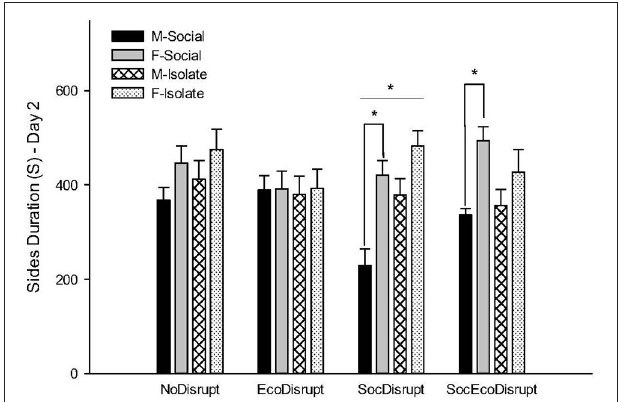
FIGURE 1 | Time spent on the sides of the arena, close to the walls, by two groups of voles: adult males (M-Social) and females (F-Social) that were socially housed and adult males (M-Isolate) and females (F-Isolate) that were housed in isolation after weaning. The behavior shown was measured on Day 2 of testing when a same-sex conspecific was placed in the center of the field. The early-life conditions were NoDisrupt (both parents with a protective cover); EcoDisrupt (both parents without a protective cover); SocDisrupt (mother with a protective cover); SocEcoDisrupt (mother without a protective cover). The bars show means ± SE, *over the bars indicates significant sex differences at p < 0.05, and -*over the bars indicates significant group differences at p < 0.05 for the SocDisrupt condition.